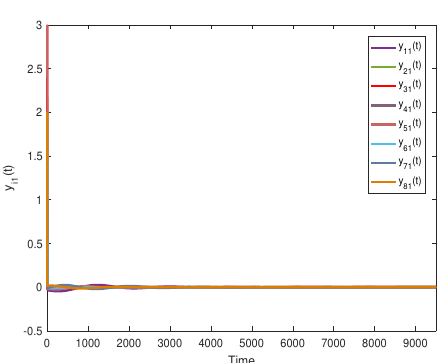
Figure 3. The states of x i 2 ( t ) .